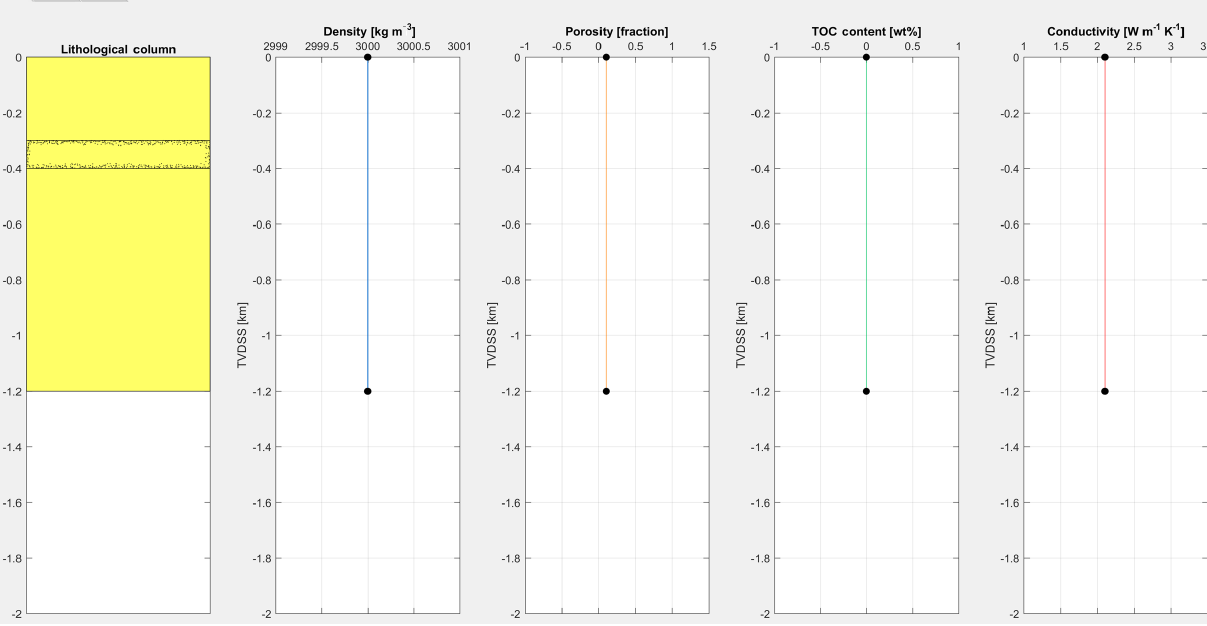
Figure 12. Input tab for the pluton